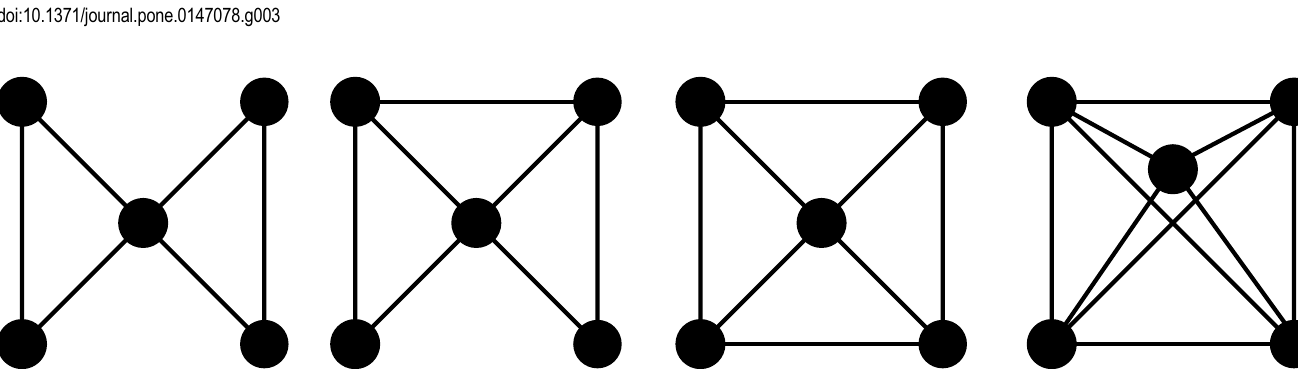
Fig 4. A motif isomorphic to graphlet 18. All other graphs contain instances of this motif, but would not if it were a graphlet. This is not a complete list of possible instances of this